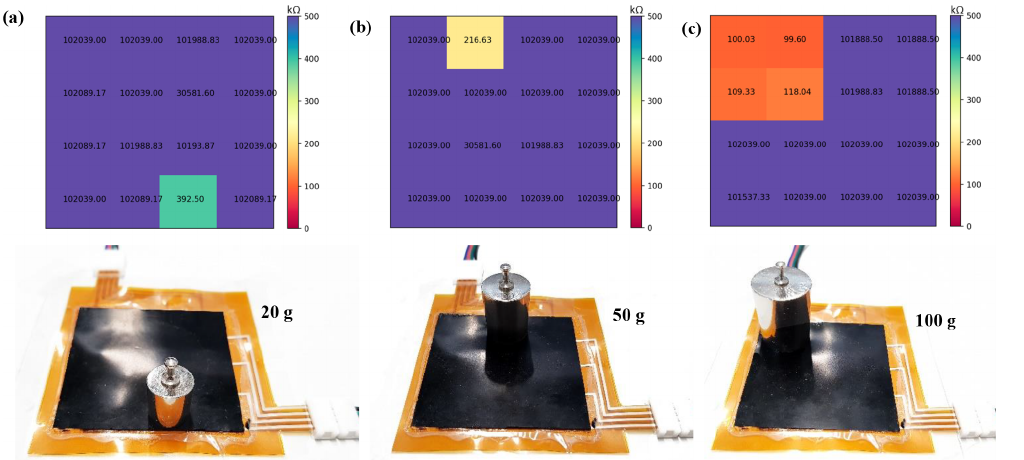
Figure 8. Pressure distribution measurement of different slotted weight measured with a 4 × 4 sensor matrix: (a) 20g, (b) 50g, (c)